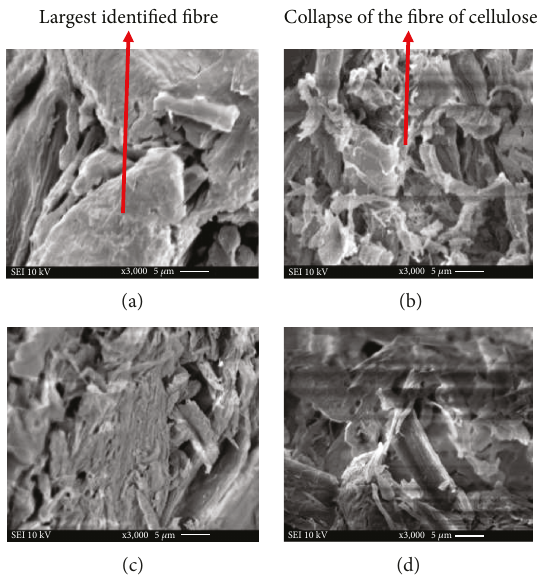
Figure 4: SEM micrographs of (a) cellulose, (b) CLE-4, (c) CLE-1, and (d) CLE-0.5 at 295